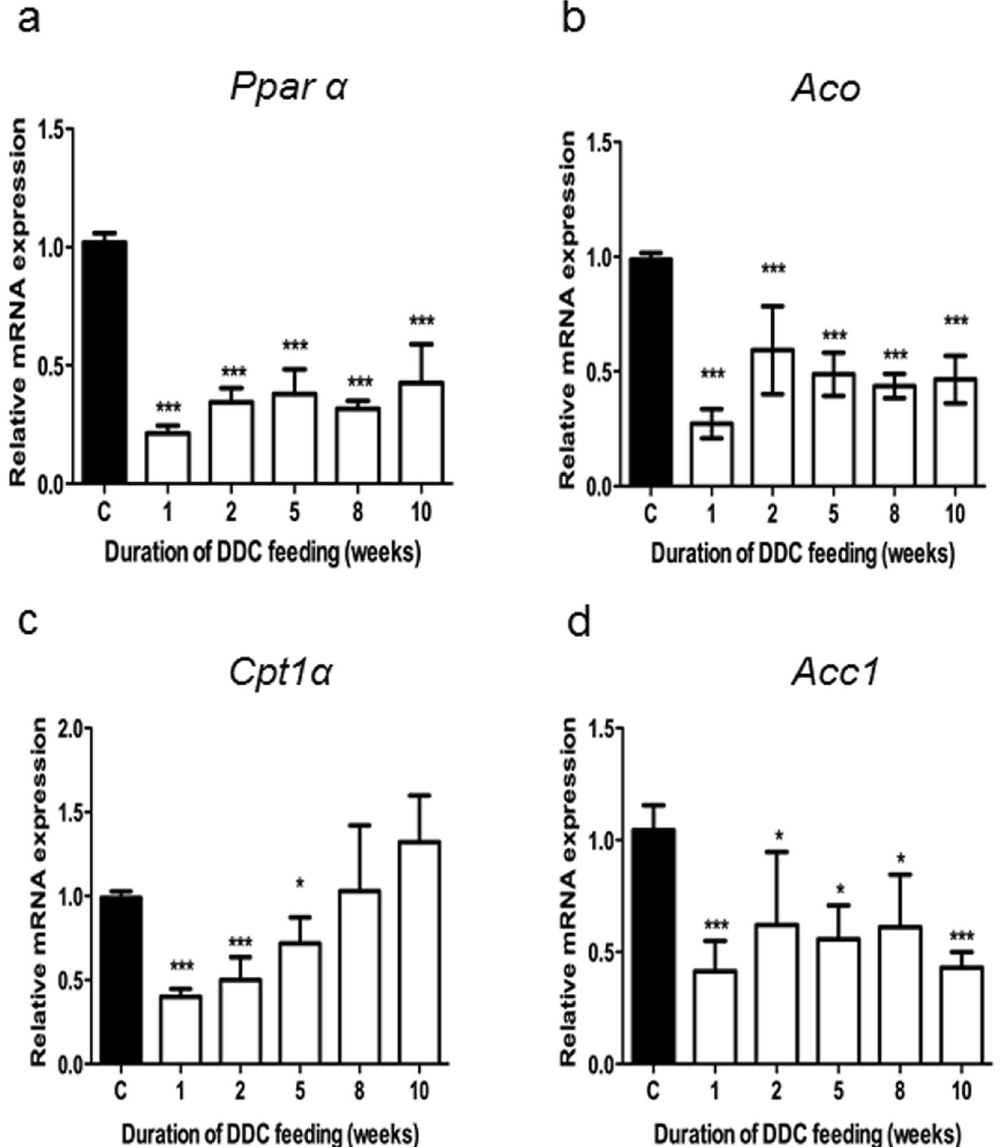
Figure 1. DDC intoxication leads to downregulation of Ppar α and lipid metabolism-related genes. Normalized expression levels of ( a ) Ppar α ; ( b ) acyl-CoA oxidase ( Aco) ; ( c ) carnitine-palmitoyl transferase 1 α ( Cpt1 α ); ( d ) acyl-CoA carboxylase 1 ( Acc1) were evaluated by qRT-PCR of mRNA extracted from whole liver tissue. Data are represented as mean ± SD collected from 5 animals per treatment group and shown as fold-change relative to controls. Significances of DDC intoxication stages are shown versus control: * p < 0.05; *** p <